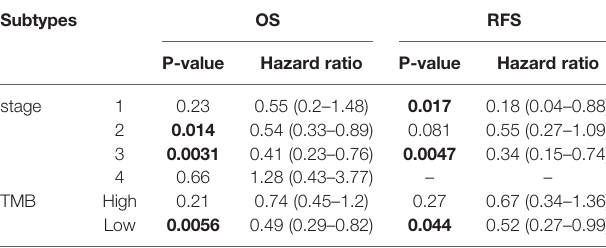
TABLE 1 | Correlation of ITGA3 mRNA expression and clinical prognosis in breast cancer with different subtypes by Kaplan – Meier plotter. Subtypes